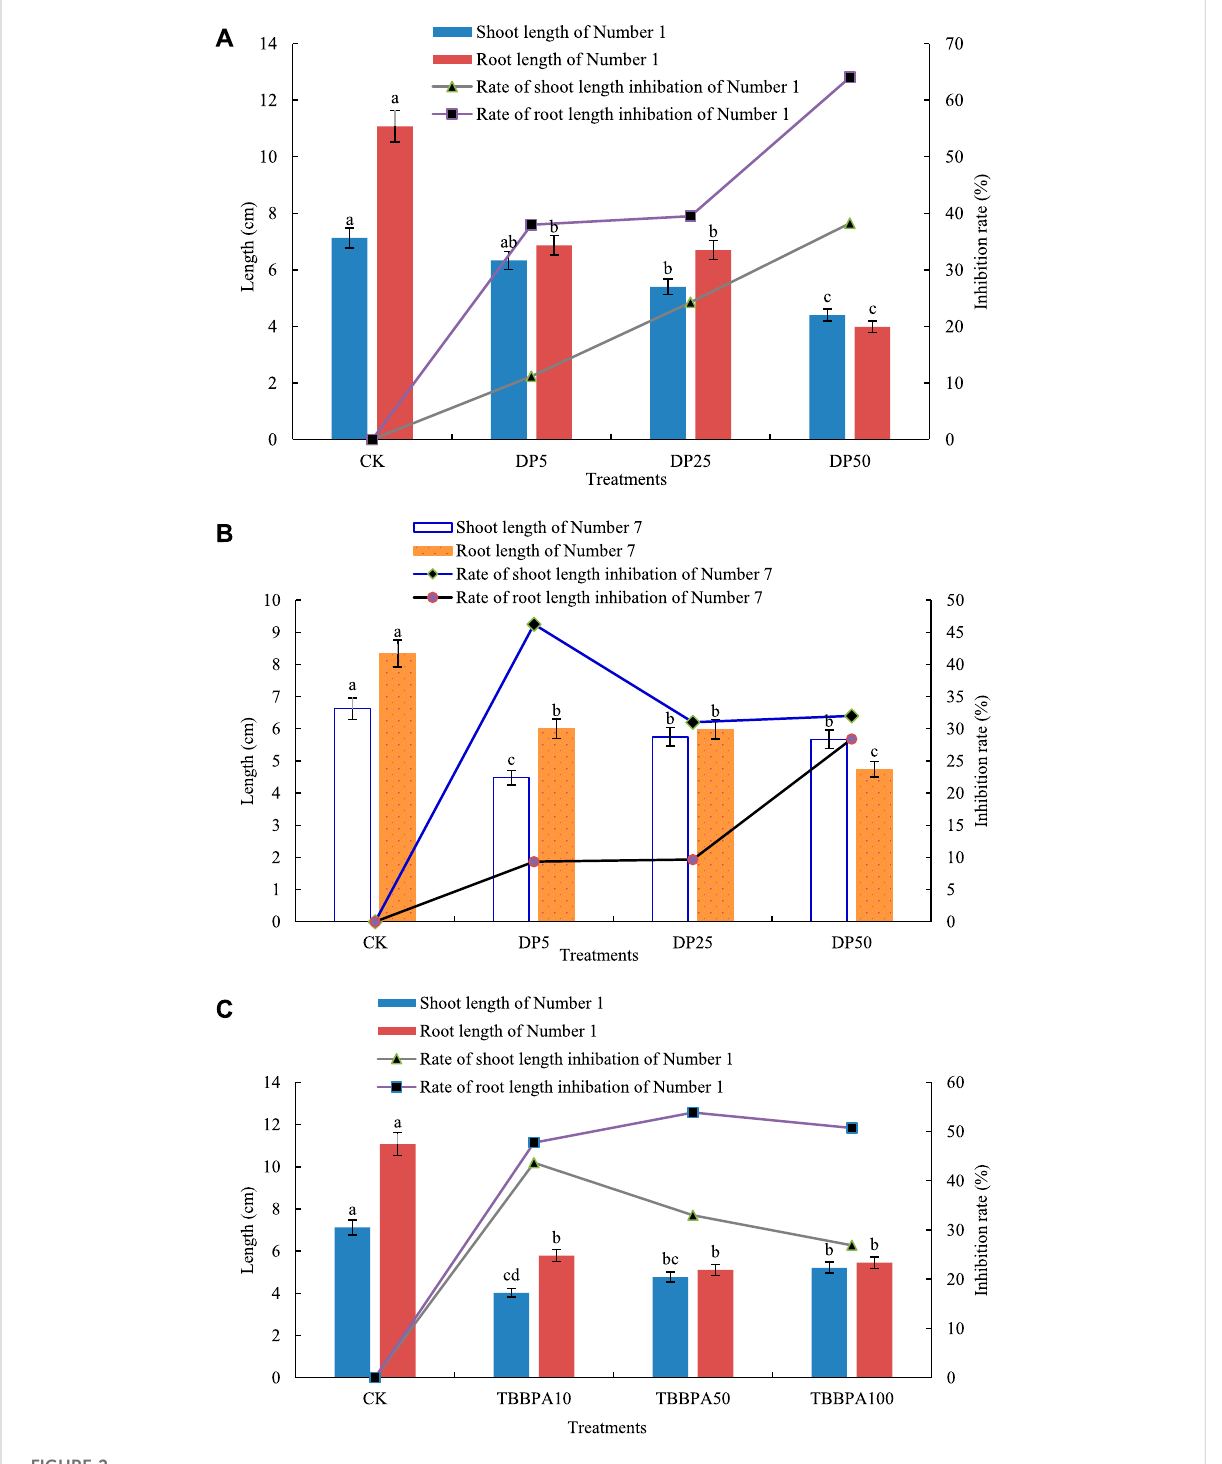
FIGURE 2 Effects of single and combined pollution of TBBPA, DP and Cd in the soil on root and shoot elongation of two rice varieties. (A) Effects on Number1riceunderDPtreatment. (B) EffectsonNumber7riceunderDPtreatment. (C) EffectsonNumber1riceunderTBBPAtreatment. (D) Effects on Number 7 rice under TBBPA treatment. (E) Effects on Number 1 rice under Cd treatment. (F) Effects on Number 7 rice under Cd treatment. (G) Effects on Number 1 rice under combined pollution treatment. (H) Effects on Number 7 rice under combined pollution